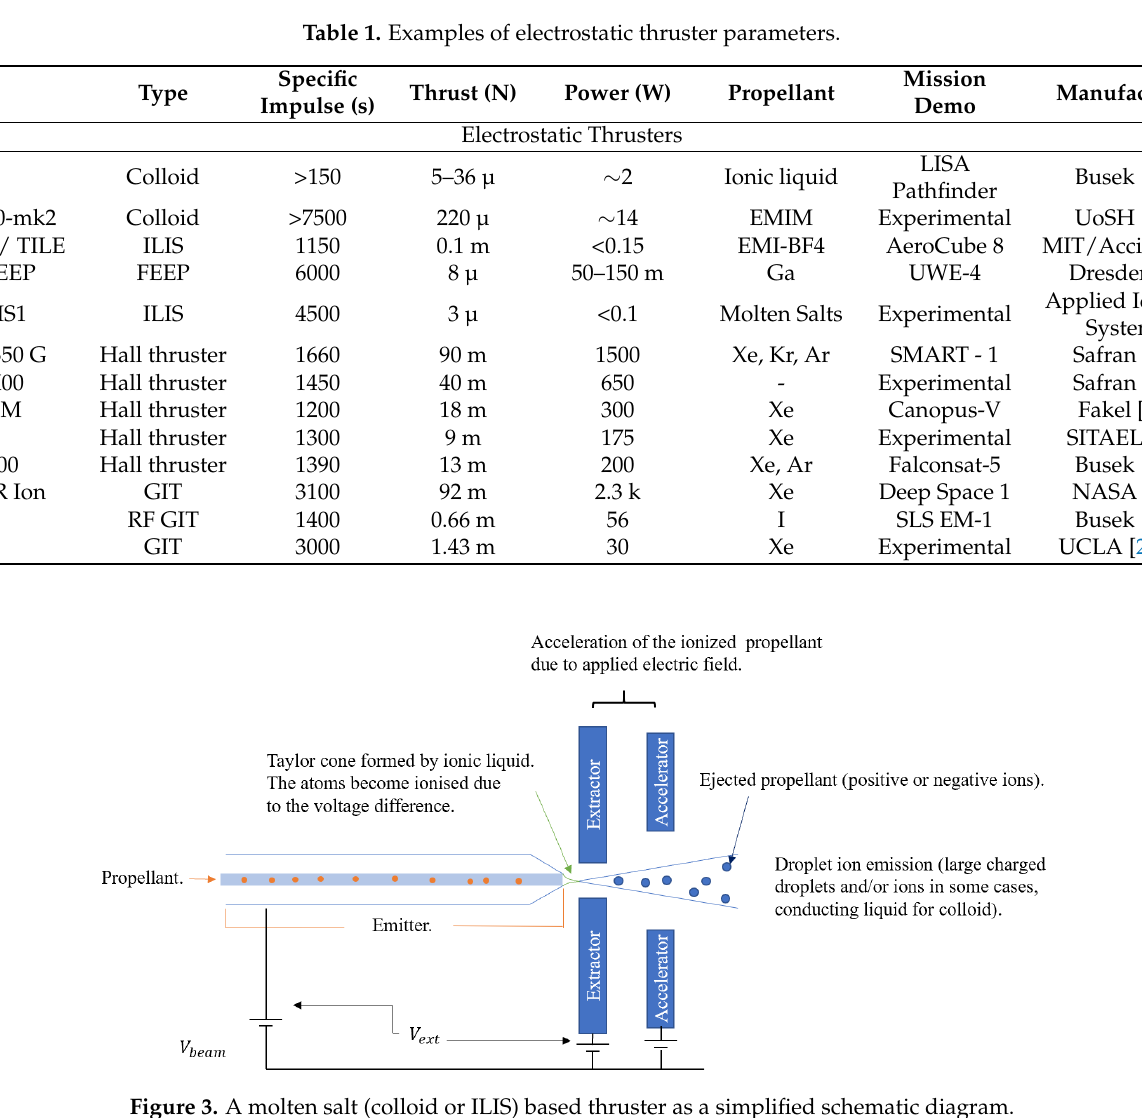
Figure 3. A molten salt (colloid or ILIS) based thruster as a simplified schematic